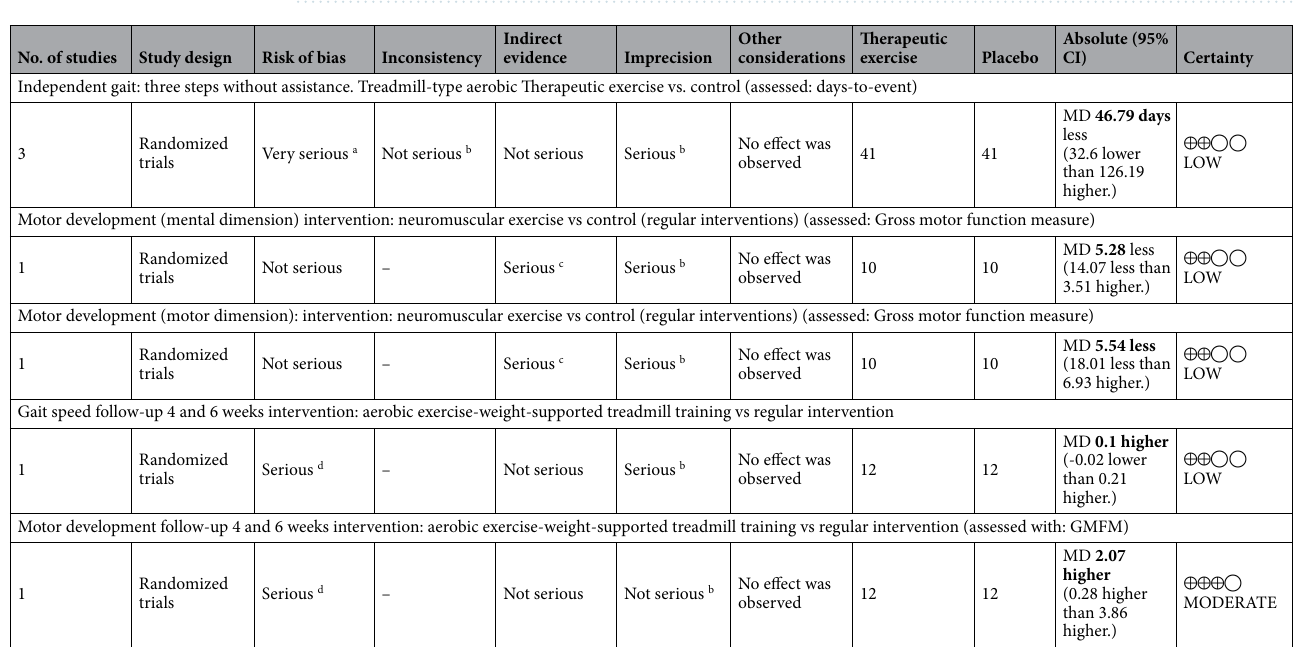
Figure 4. Aerobic exercise (treadmill) versus control (activities of daily living) outcome: independent gait, time(days)-to-event.